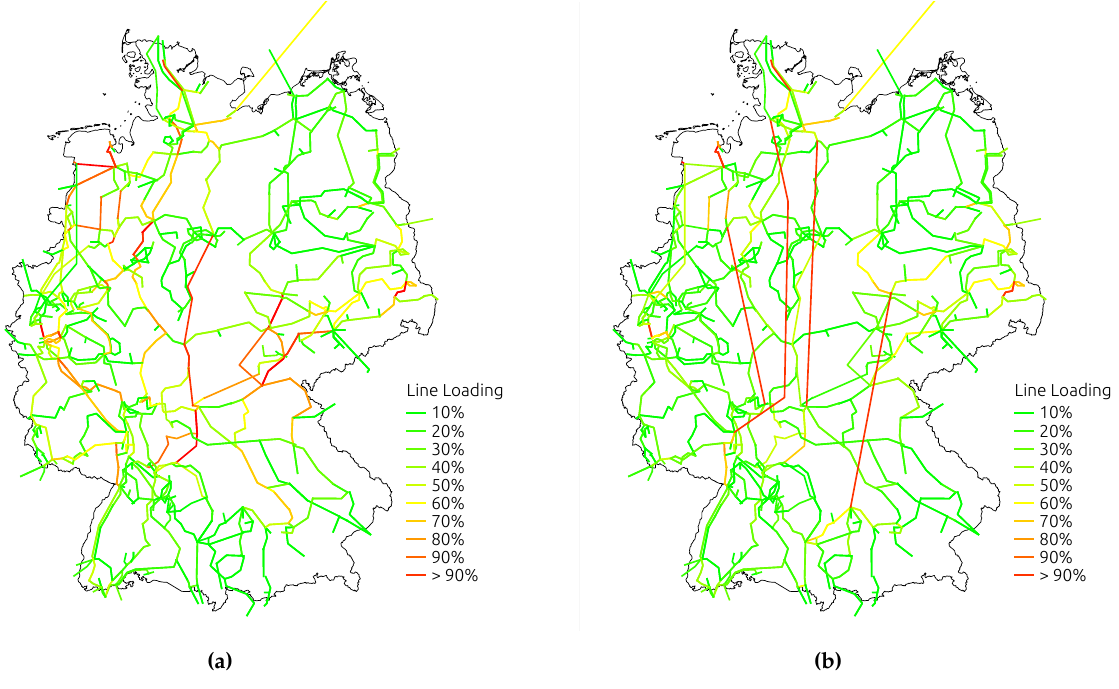
Figure 7. Line loading at 12:00 on 21 June 2020 in Germany’s transmission system, with and without the planned High Voltage Direct Current Lines (HVDC) reinforcements in the grid. ( a ) Planned HVDC projects incomplete; ( b ) Planned HVDC projects complete.